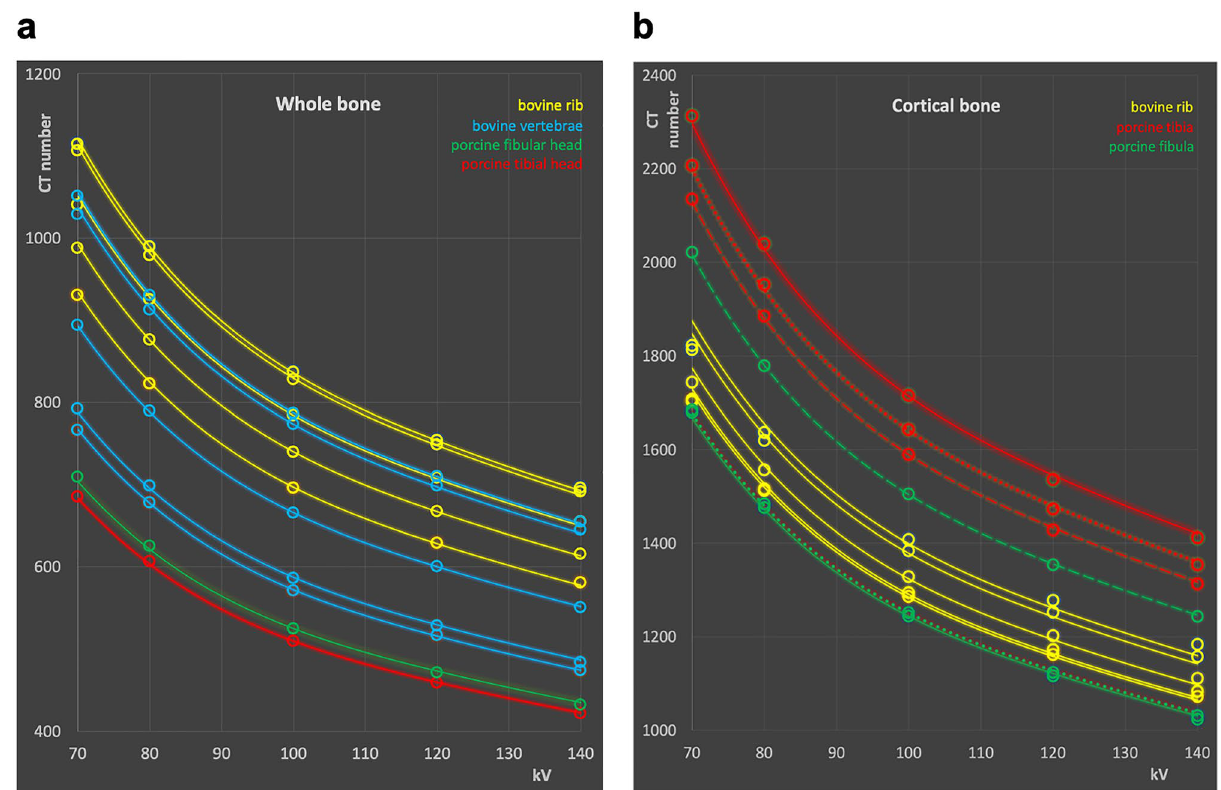
Figure 1. CT numbers measured in the bone samples. ( a ) Whole and ( b ) cortical bone. Circles indicate measured CT values; lines correspond to model equations. Broken lines in ( b ) indicate measurements in the distal porcine tibia or fibula, solid lines in the mesial part, and dotted line measurement over the whole bone shaft, hard bone, and their CT values determined. The segmentation of the bone in volumes with different bone densi- ties allows the determination of the CT values, and, more interestingly, their change with kV for all densities of cancellous bone encountered, as well as for bone tissue exceeding the density of the total cortical bone samples described above. Figure 2a shows CT values of the bone regions corresponding to extremely soft to very hard bone together with their energy dependence from segmented bone density regions in the porcine tibial head, the bovine ribs, and vertebral bodies from the oxtail samples. Soft and adipose tissues. HU measurements of soft (diamonds) and adipose tissues (circles) sampled in the bovine and porcine specimen are shown in Fig. 2b. In soft tissues, no deviation from a flat energy response is found as anticipated. However, samples with highest HU tendentially exhibit a slightly increasing CT value at the soft energy end at 70 kV, while those with lowest CT numbers show a slight reduction. This indicates possible partial volume effects. The adipose tissue samples comprising subcutaneous and visceral fat exhibit average CT numbers between − 39 and − 89 HU at 120 kV with a strong decrease in HU towards softer spectra in accordance with the lower effective atomic number of adipose tissues compared to water. Modelling the energy dependence of the tissues. Using all available data from whole bone, cortical bone, and bone segmented in regions with different hardness, a mathematical description the dependence of the CT value on the tube potential for bone tissues was derived. The underlaying idea is, that a single measure- ment of the CT value at a reference tube potential, in this case 120 kV, is used to calculate the CT numbers of the respective bone tissue at all other kV values from 70 to 140: the CT value as a function of the kV, HU(kV), is modelled based on the CT value measured at a reference kV value of 120 kV (HU(120)) as